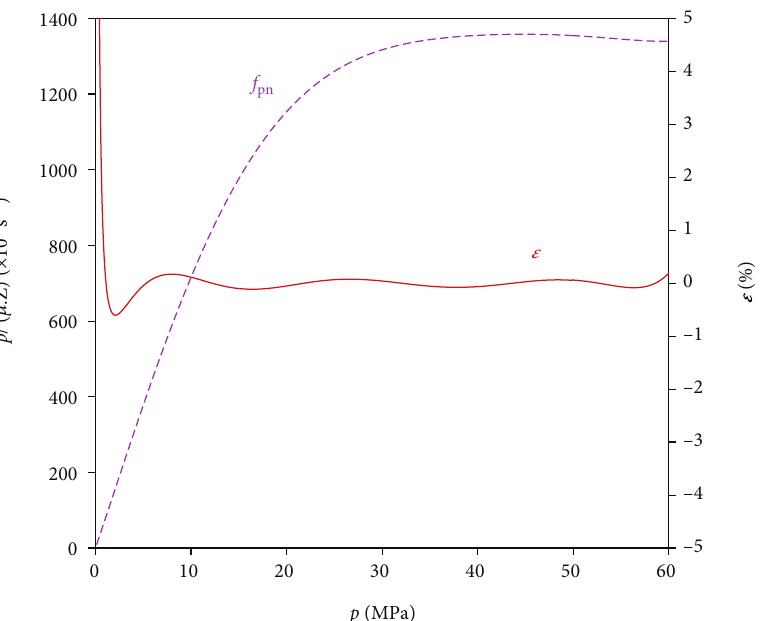
Figure 6: The relation curves of p / ð μ Z Þ and ε vs. p calculated by the polynomial function f